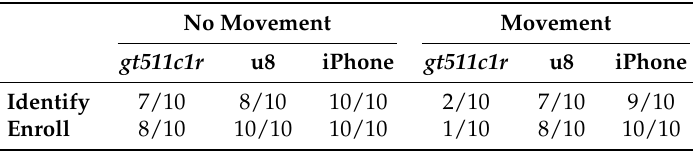
Table 4. Comparison of the effectiveness of the gt511c1r , Oukitel u8 and iPhone 6 scanners.